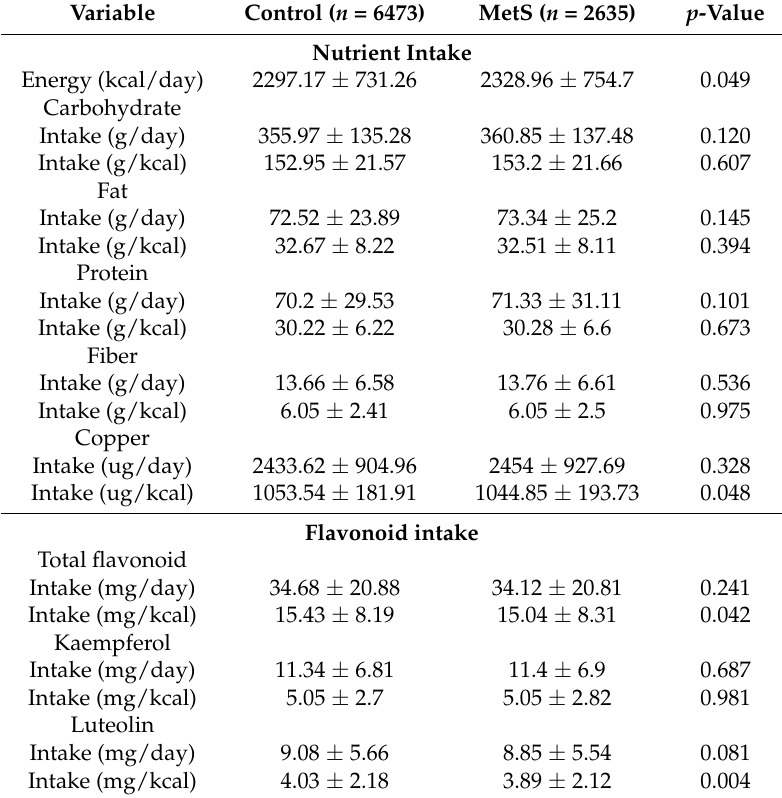
Table 2. Dietary nutrient and flavonoid intakes of the subjects from Harbin Cohort Study on Diet, Nutrition, and Chronic Non-Communicable Diseases